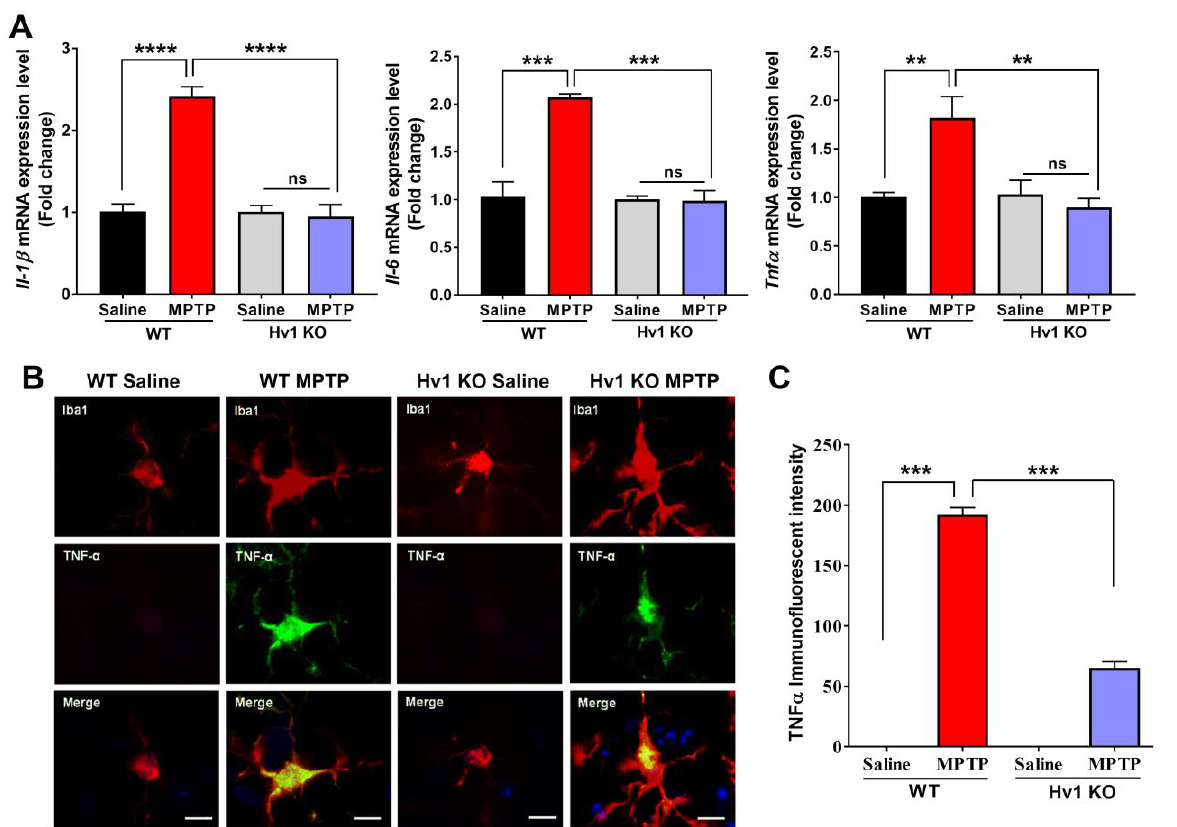
Figure 4. Hv1 KO mice exhibit attenuated MPTP-induced pro-inflammatory cytokine production. ( A ) Quantitative PCR results demonstrate that Hv1 KO mice completely abolish the MPTP-induced mRNA levels of the inflammatory cytokines Il-1b ( left ), Il-6 ( middle ), and Tnfa ( right ) compared to WT mice 2 days after MPTP treatment. ( B ) Representative immunofluorescent images of TNFα (green) in IBA1-positive (red) cells, with DAPI nuclei stain (blue) in WT and Hv1 KO sections treated with saline or MPTP, scale bar 5 μm. ( C ) Semi- quantification of TNFα protein fluorescent intensity levels. n = 4 – 5 mice per group for all experiments. Asterisks denote statistically significant differ- ences, ** p < 0.01, *** p < 0.001, and **** p < 0.0001, using two- way ANOVA followed by Tukey’s multiple comparisons. ‘ns’ indicates not statistically significa nt. Error bars denote the standard error of the mean.